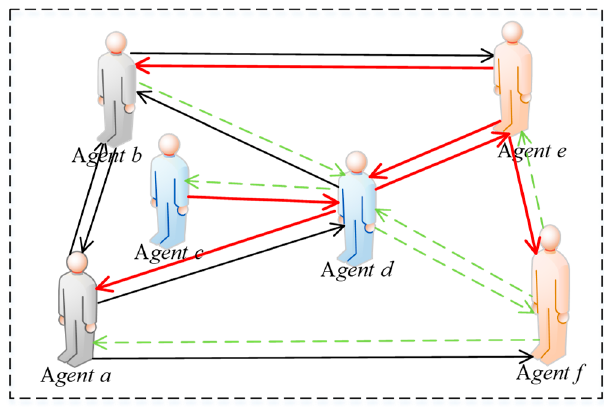
Figure 7. Intimacy modification diagram.